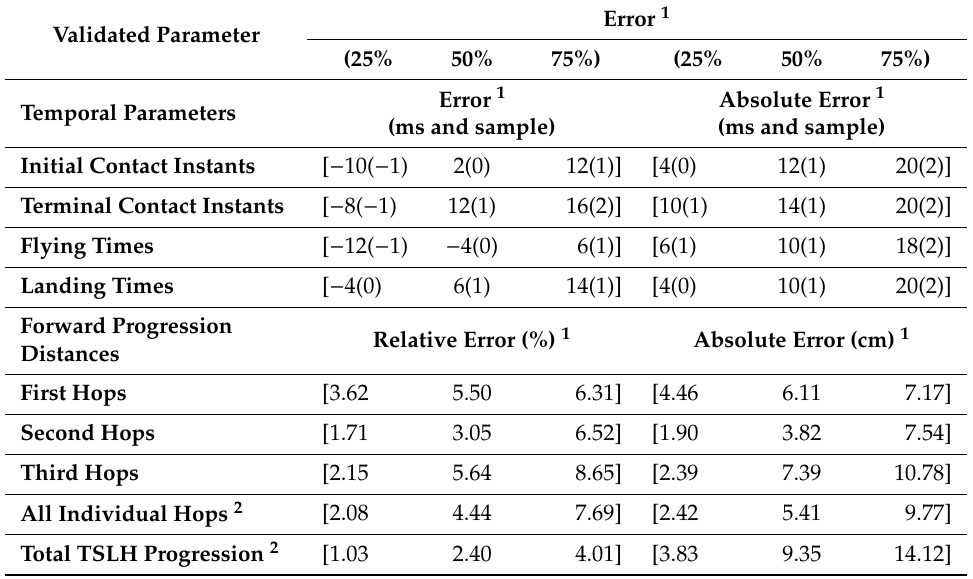
Table 2. Errors of the proposed IMU system in the estimation of temporospatial parameters of TSLH against the motion-capture system. Results are expressed as 25%, 50%, and 75% percentiles of error, calculated for all 60 individual hops (20 TSLH trials, 3 hops each) performed by the 10 able-bodied participants. The values in parentheses for the temporal parameters express errors in terms of the time sample of the motion-capture system (10